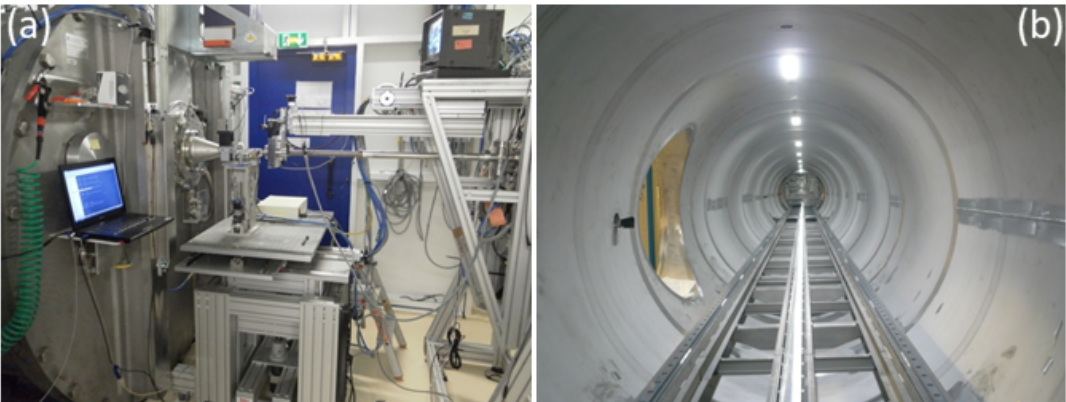
Figure 4. Experiment station at ID02 beamline at the ESRF. ( a ) The photo displays the sample table and stages, incident side telescopic tube, and the entrance cone of the detector tube. ( b ) Inside view of the 34 m long and 2 m diameter detector tube showing the detector carriage at the end.